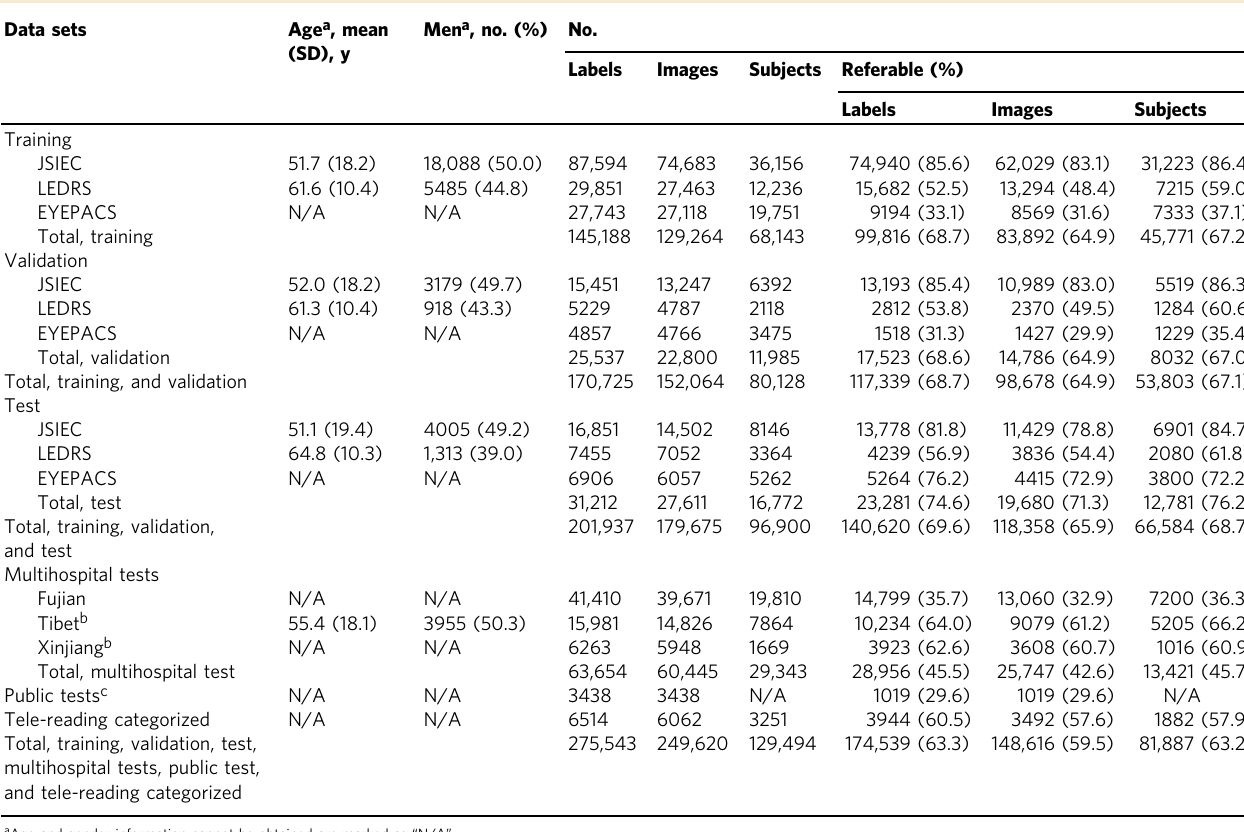
Publictestsincludefourpublicdatasetsinsingle-diseasesetting:Messidor-2,IndianDiabeticRetinopathyImageDataset(IDRID),PathologicalMyopia(PALM),andRetinalFundusGlaucomachallenge